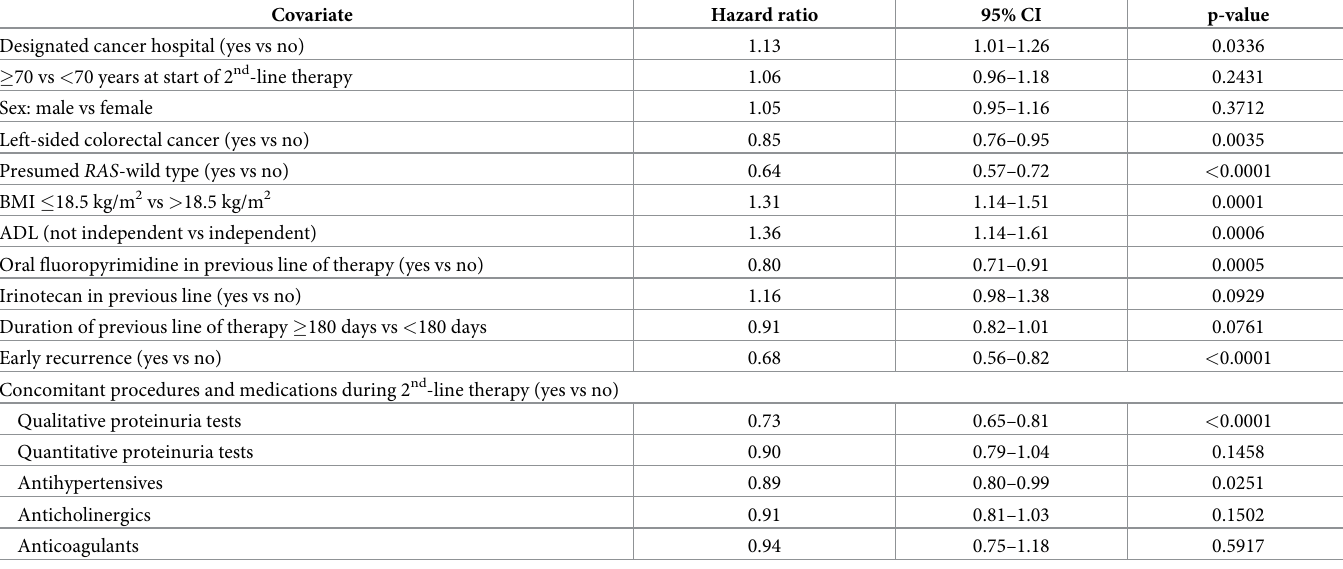
Table 4. Multivariate Cox regression analysis for the factors associated with overall treatment continuation from the start of second-line therapy to the end of all antitumor drug therapies in the FOLFIRI plus antiangiogenic drug subpopulation.